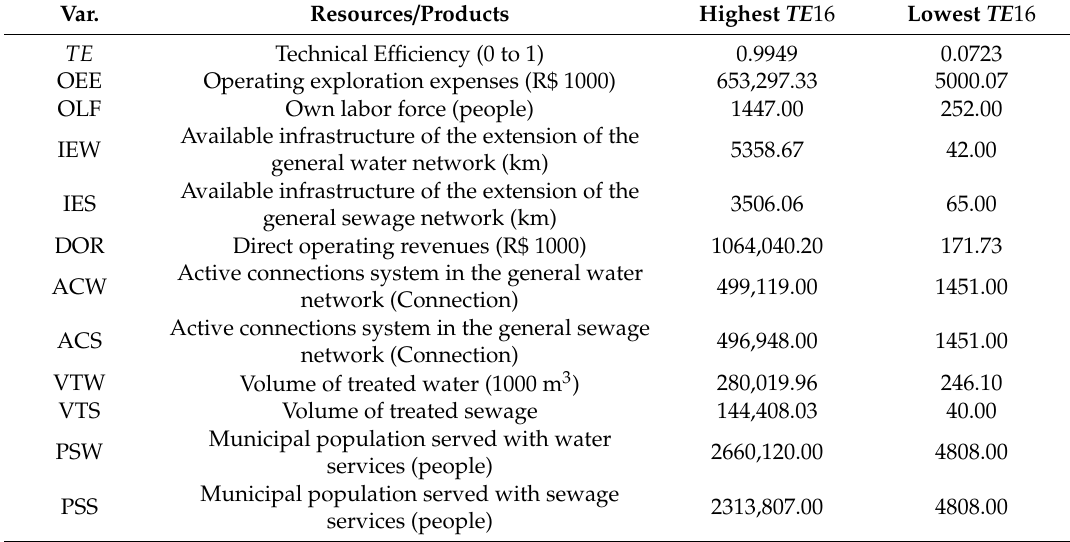
Table A4. Comparison of the company’s inputs and products with the highest TE value (benchmark) and the lowest TE value.